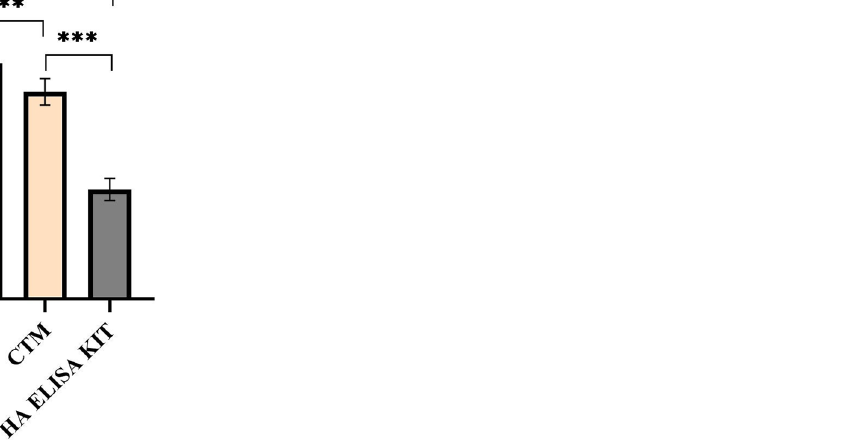
Figure 6. Comparison of HA concentration in transgenic hairy roots, measured by Carbazole, CTM, and HA ELISA kit. Quantities are in g/kg (wet weight). The Student’s t-test was used for the HA data. The values are expressed as mean ± standard error (SE). **p < 0.01, ***p <